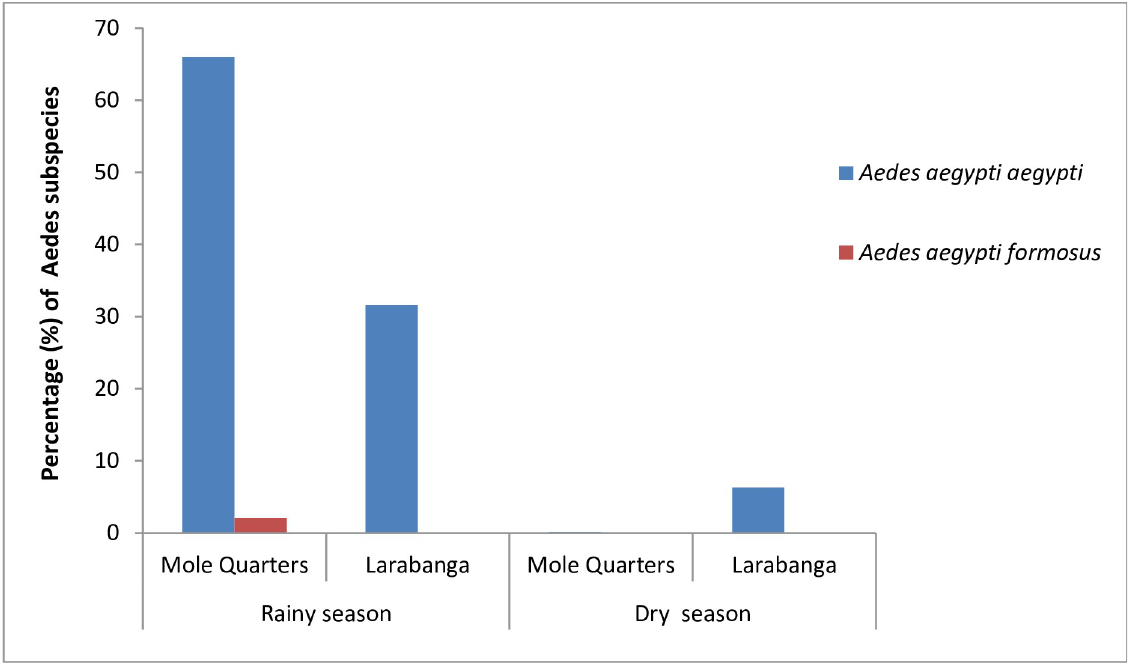
Fig 2. Seasonal distribution of Aedes aegypti sub-species in the study areas.